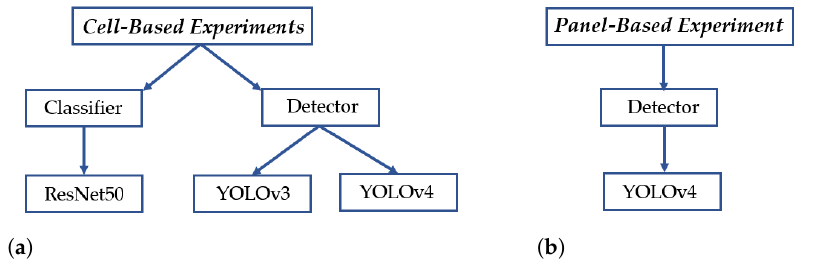
Figure 14. The organization of experimental comparisons. ( a ) Cell-image-based experiments. ( b ) Panel- image-based experiments.